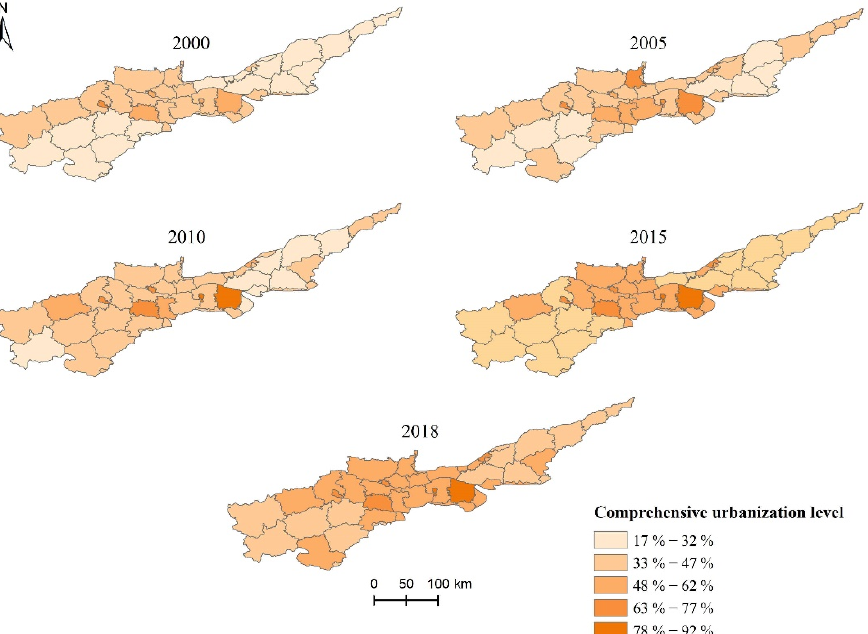
Figure 8. Spatiotemporal distribution patterns of comprehensive urbanization in the AYRHP on the county scale.